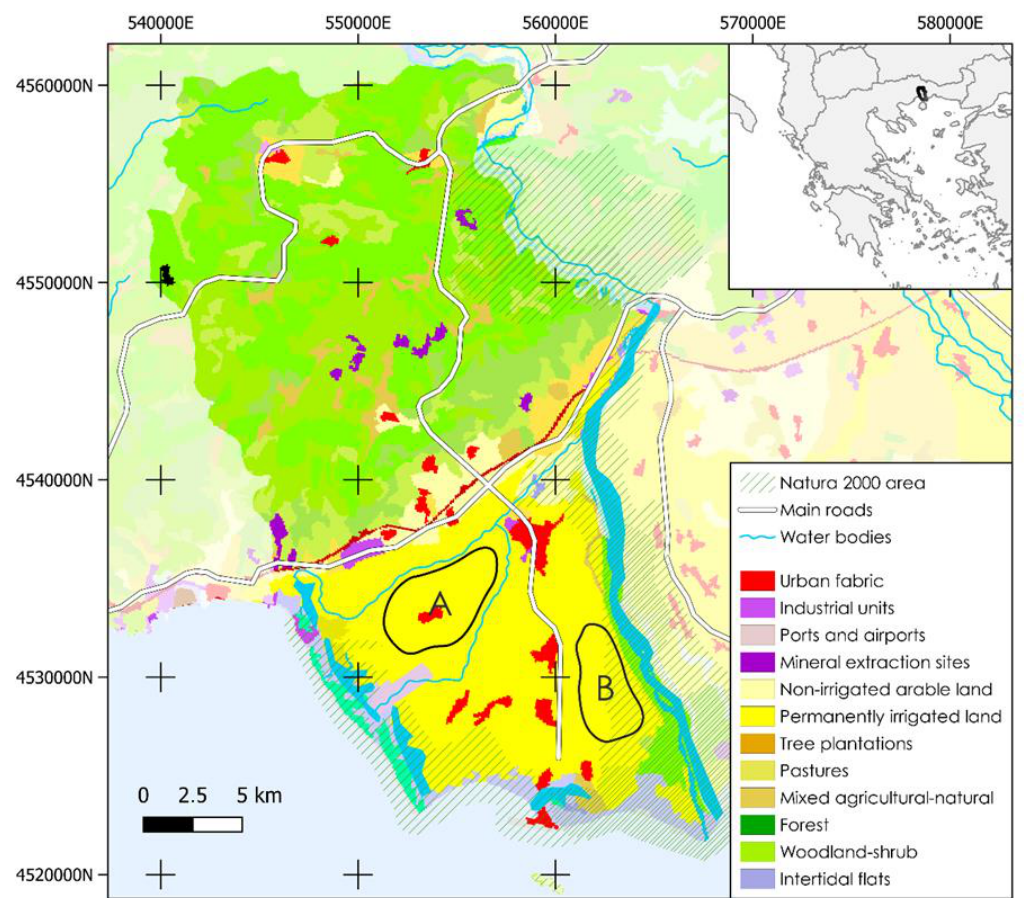
Figure 1. Location of the two study areas in the municipality of Nestos. Area A is located near urban and road infrastructures, while area B is adjacent to a large water body and woodland, designated as a Natura 2000 protected area. Data sources: Corine Land Cover (2018), EEA (2022) and GADM